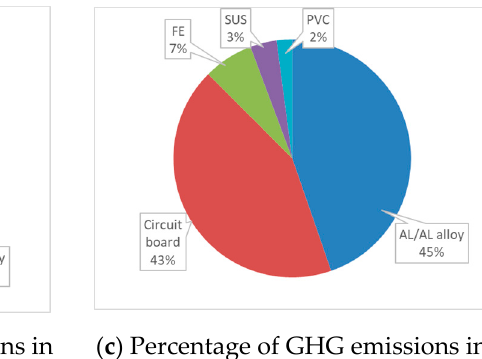
Figure 6. Comparison of recycling profits for each component in Korea and Japan.